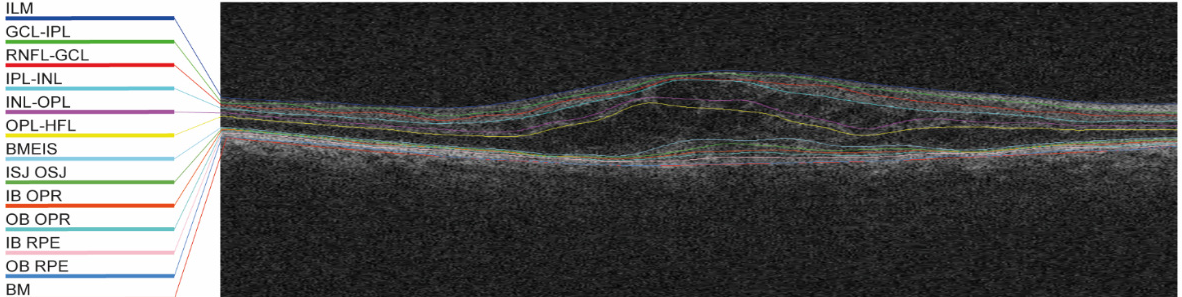
Figure 1. Example of the automated layer segmentation of 13 retinal layers. BM, Bruch’s membrane; BMEIS, boundary of myoid and ellipsoid inner segments; GCL-IPL, ganglion cell layer-inner plexiform layer; IB OPR, inner boundary outer photoreceptor; IB RPE, inner boundary retinal pigment epithelium; ILM, internal limiting membrane; INL-OPL, inner nuclear layer-outer plexiform layer; IPL-INL, inner plexiform layer-inner nuclear layer; ISJ OSJ, inner segment/outer segment junction; OB OPR, outer boundary outer photoreceptor; OB RPE, outer boundary retinal pigment epithelium; OPL-HFL, outer plexiform layer-Henle’s fiber layer; and RNFL-GCL, retinal nerve fiber layer-ganglion cell layer.